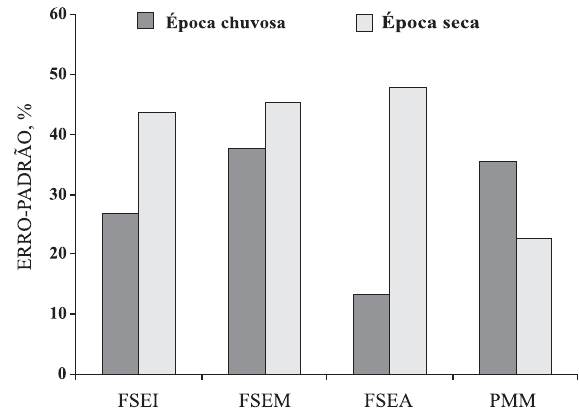
Figura 2. Variação sazonal do erro-padrão da densidade média da macrofauna do solo